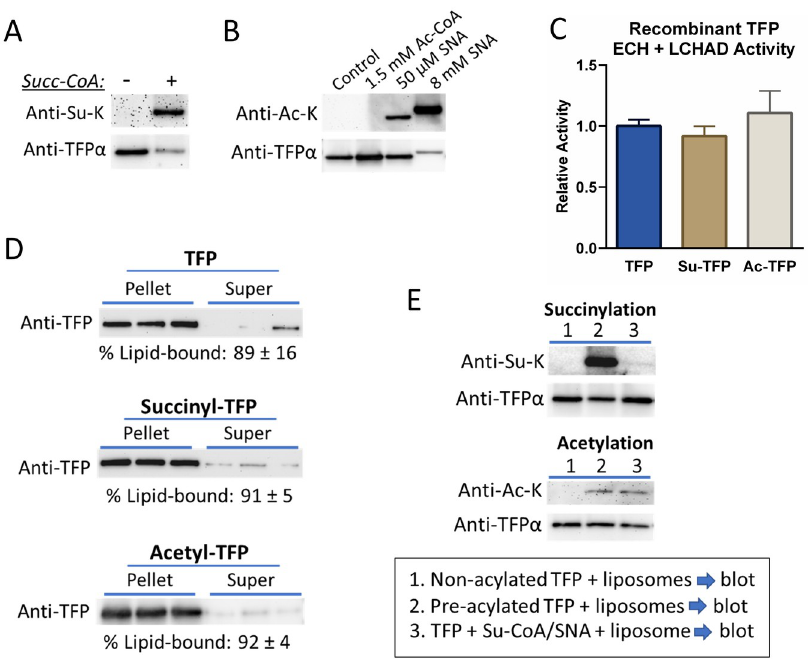
Fig 5. Acylation of recombinant TFP does not alter activity or membrane binding. A) Recombinant human TFP treated with 0.5 mM succinyl-CoA for 30 minutes exhibits lysine succinylation as shown by anti-succinyllysine immunoblotting of 100 ng of TFP protein. B) Optimization of in vitro acetylation conditions for TFP. Shown is an anti-acetyllysine immunoblot of TFP (100 ng per lane) treated with acetyl-CoA (1.5 mM) versus the acetylating agent sulfo-NHS-acetate (SNA) at either 50 μ M or 8 mM. SNA at 50 μ M was chosen for subsequent experiments. C) Recombinant human TFP α enzyme activities in the forward direction with 25 μ M 2-enoyl-C 16 -CoA after succinylation and acetylation as described in panels A and B. Bars represent means and standard deviations of three biological replicates each assayed 3–4 times (10 total activity measurements), normalized to untreated control TFP. D) Triplicate samples of untreated control recombinant human TFP, succinylated TFP, and SNA-acetylated (50 μ M) TFP were incubated with cardiolipin-containing liposomes for 30 minutes and then ultracentrifuged. The lipid pellet and supernatant fractions were then blotted with anti-TFP α antibody. Densitometry was used to estimate the % of lipid- bound TFP in the pellet fraction (shown below each immunoblot), which did not change with lysine acylation. The entire experiment was repeated with similar results. E) The effect of cardiolipin liposomes on the acylation of recombinant TFP was tested by either pre-acylating the protein for 30 min (condition #2) or mixing protein, acylating agent, and liposomes all at once for 30 min prior to blotting (condition #3). The entire experiment was repeated a second time with similar